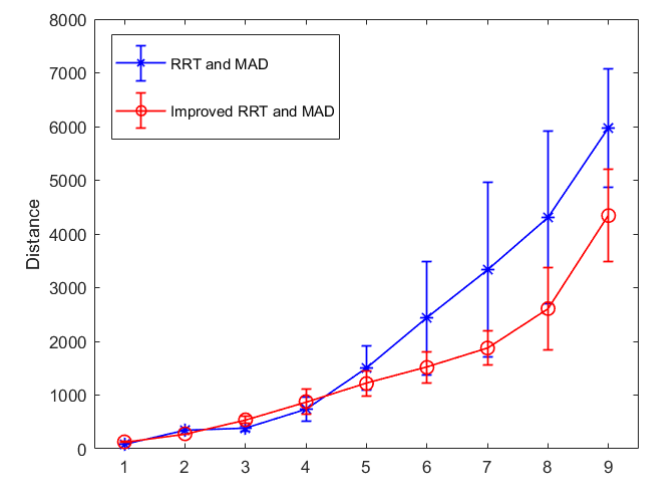
Figure 19. Curve fitting and MAD comparison.